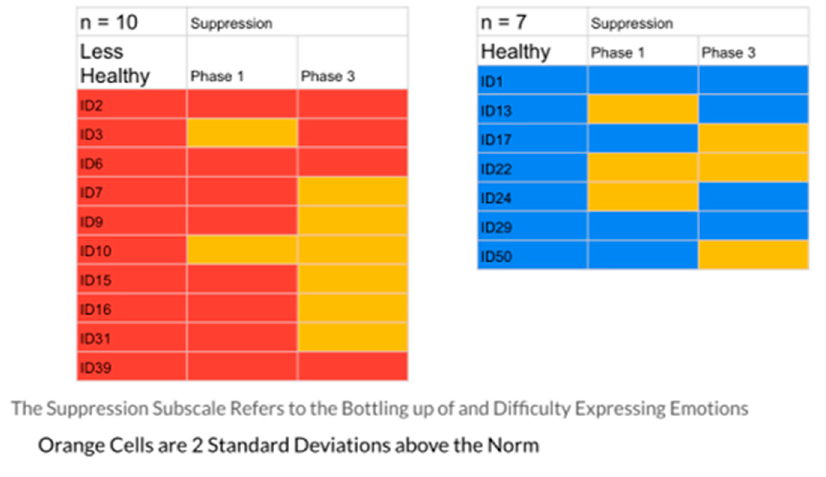
Figure 1. The Suppression Scale EPS: Less Healthy vs. Healthy Coping Groups.